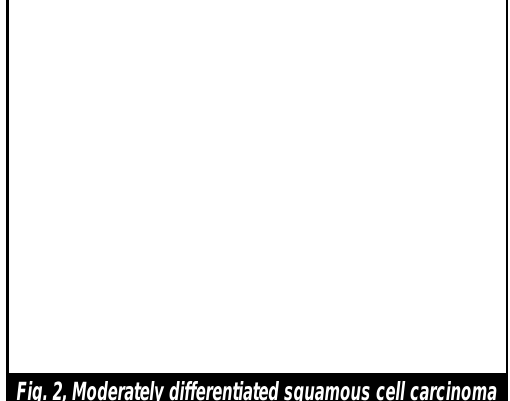
Fig. 2, Moderately differentiated squamous cell carcinoma arising in a mature cystic teratoma of ovary. (H&E,x10)